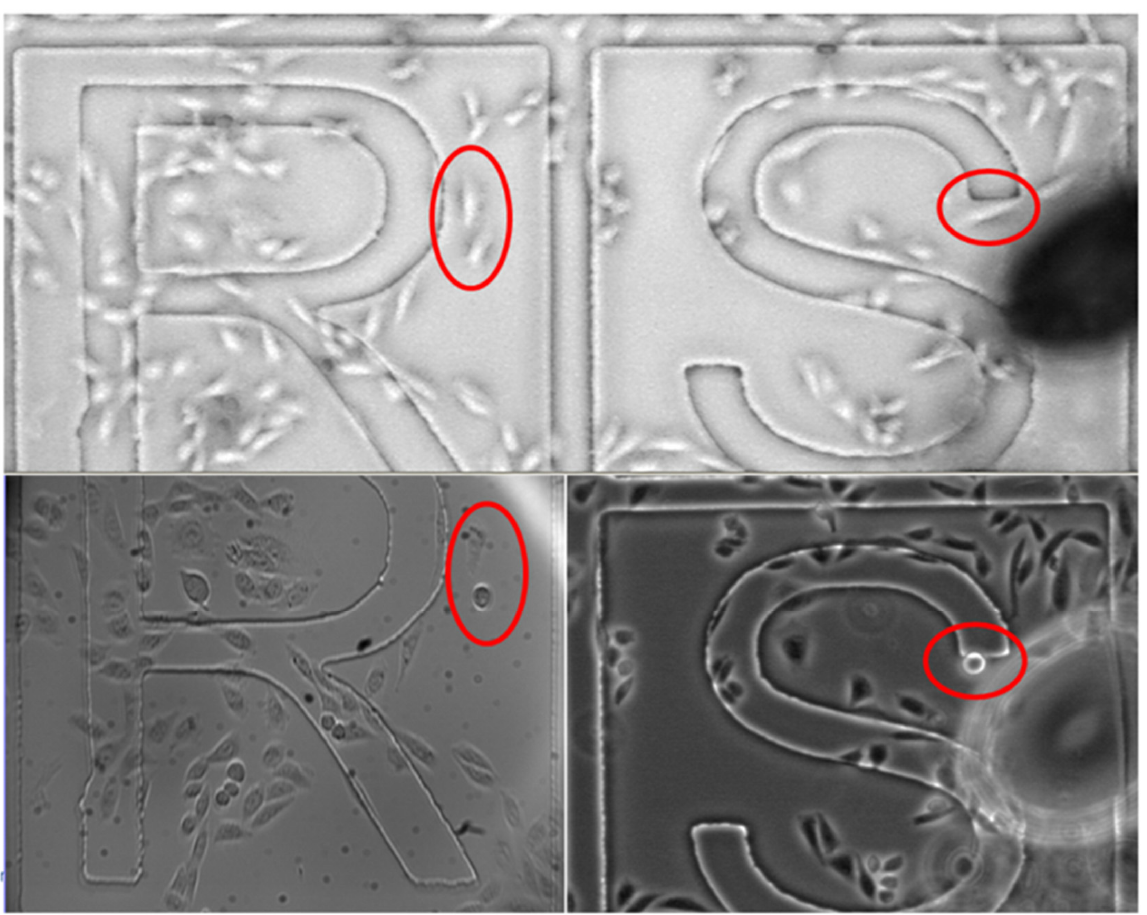
Figure 3. Example of CHO cells changing morphology from the expected longitudinal (circled cells in the top panels) to round shape (circled cells in the bottom panels) upon exposure to the focused laser beam (24 mW, 60 s). Each letter section above with cells has dimensions of 500 μ m × 500 μ m.